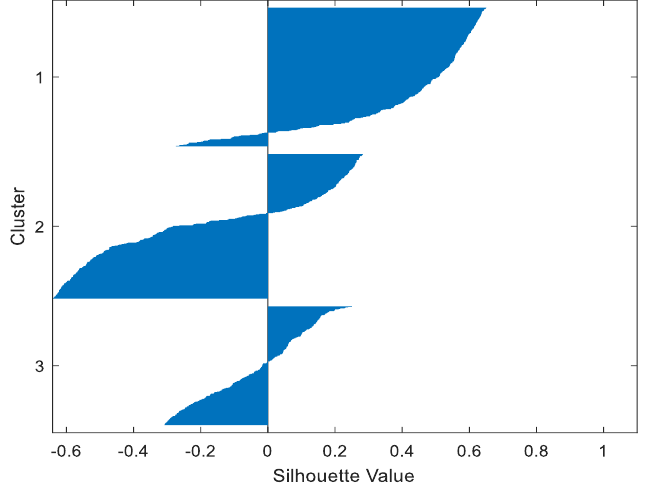
Figure 16. Pima FCM.